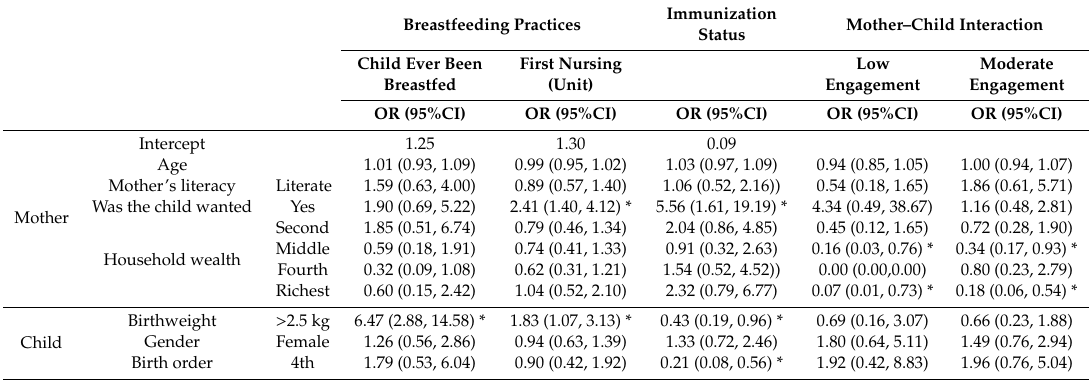
Table 3. Predictors of parental